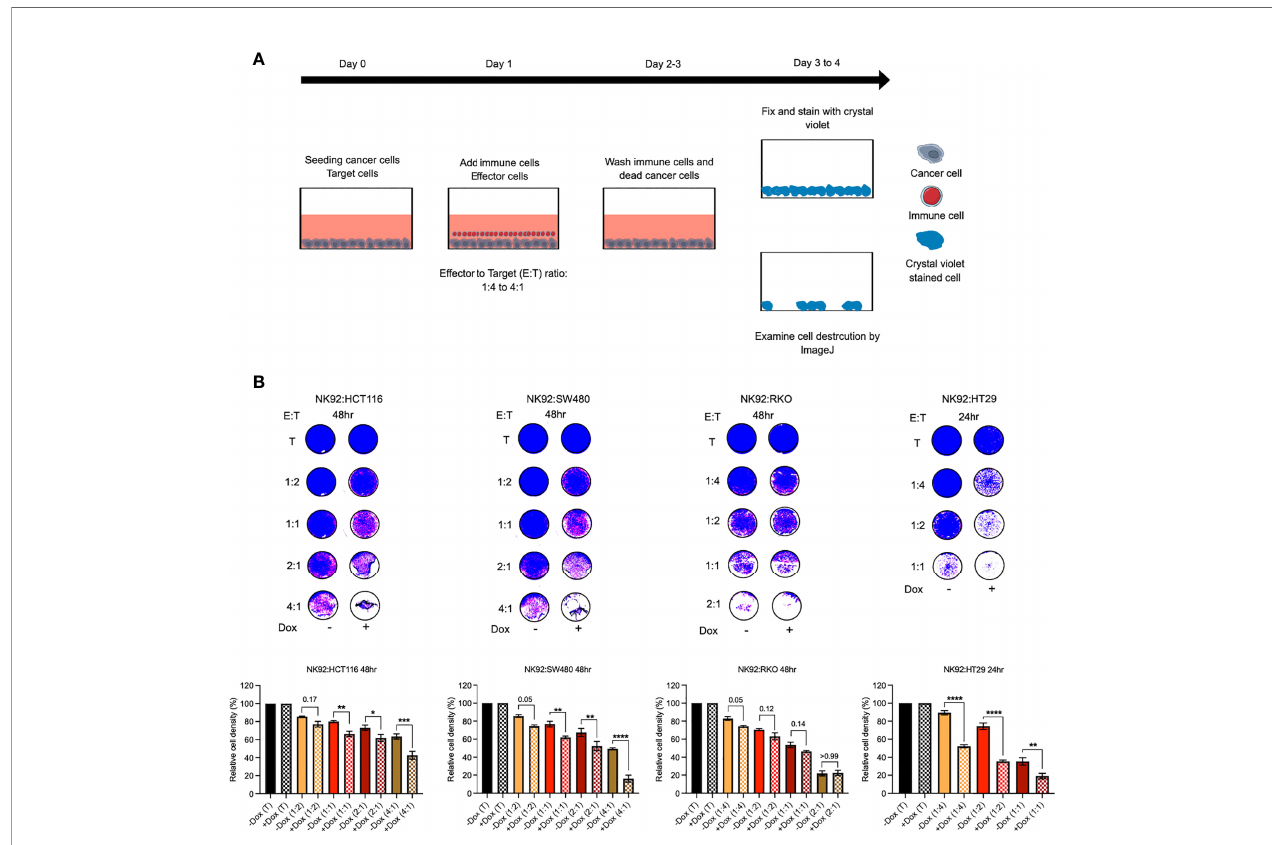
FIGURE 12 | ILK KD in the epithelial CRC cells increased sensitivity to NK92 immune cell cytotoxicity. (A) The schematic illustration of co-culturing NK92 immune cells with CRC cells. At 0 time point the optimal -Dox and +Dox CRC cells number (target, T) were seeded into a 96-well plate. The following day after CRC cells adhesion, the immune cells (effector, E) were added over the target cells at different ratio (E:T). The immune cells were incubated for either 24hr or 48hr depending on CRC cell lines. Then, immune cells and any dead cancer cells were washed off by gently media change. The remaining adherent cells then were incubated for 24hr before fi xing and staining. Following staining with crystal violet, the plates were imaged and cell densities and destruction by effector cells were quantitated by ImageJ software. (B) Killing activity of NK92 immune cells against the CRC cells. The control (T, target only) was replaced with only media without effector cells. The quantitation of cell density was normalized to control. Statistical signi fi cance ( P < 0.05) was calculated by Ordinary One-way Anova with multiple comparisons. Error bars are represented as mean ± SEM (n = 3). P- value < 0.05 is signi fi cant. * (0.05) ** (< 0.01), ***(< 0.001) and **** (<